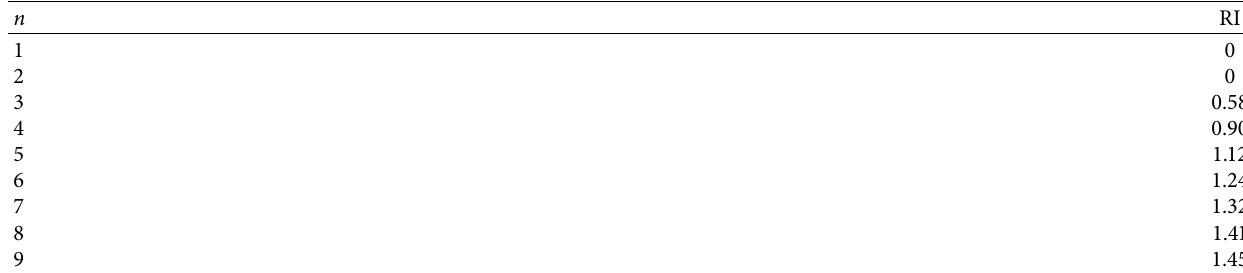
Table 5: RI values of average random consistency index.